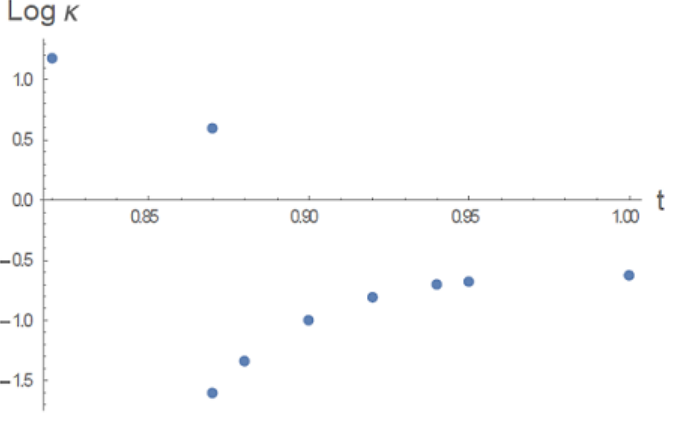
Figure 7. Bulk modulus κ as a function of reduced temperature t through the collapse transition at t = 0.87, (cid:36) 0 =